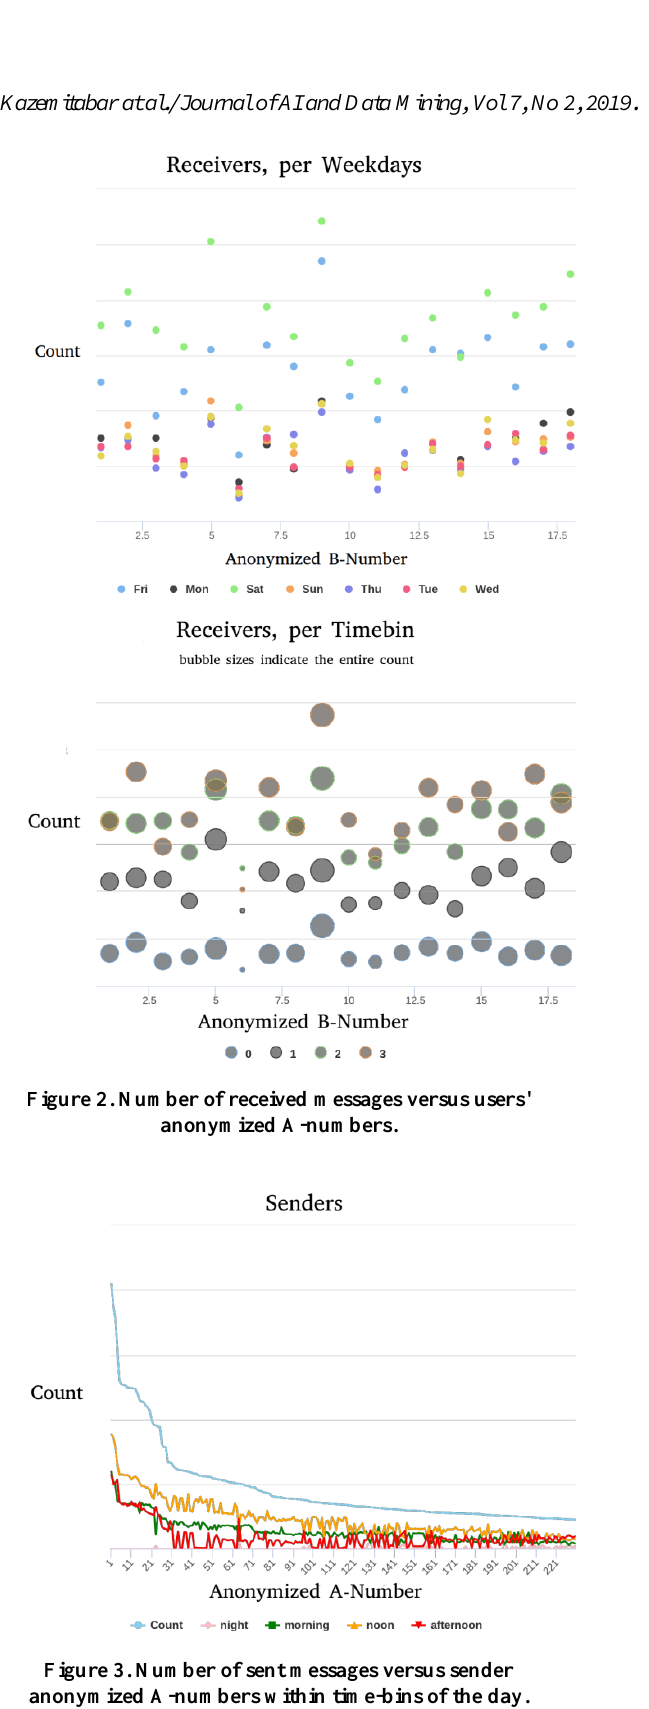
Figure 4. Top risky